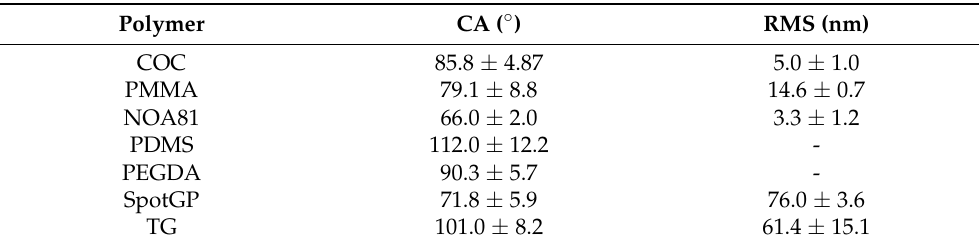
Table 3. Wettability (CA) and roughness (RMS) of the polymeric materials. Standard deviations are shown.